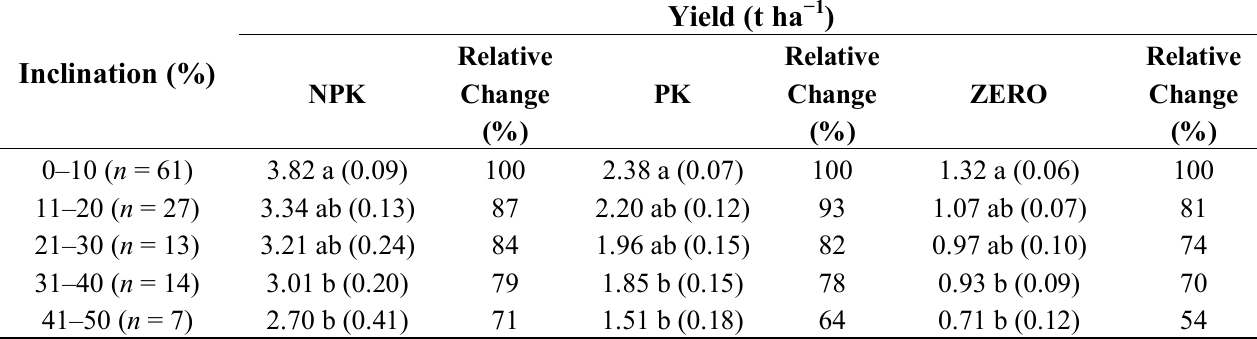
Table 3. Maize yields of Nitrogen, Phosphorus and Potassium (NPK, PK) recommended mineral fertilization and without fertilizer (ZERO) mineral fertilizer treatments in baseline landscape positions, and relative change using 0%–10% as the